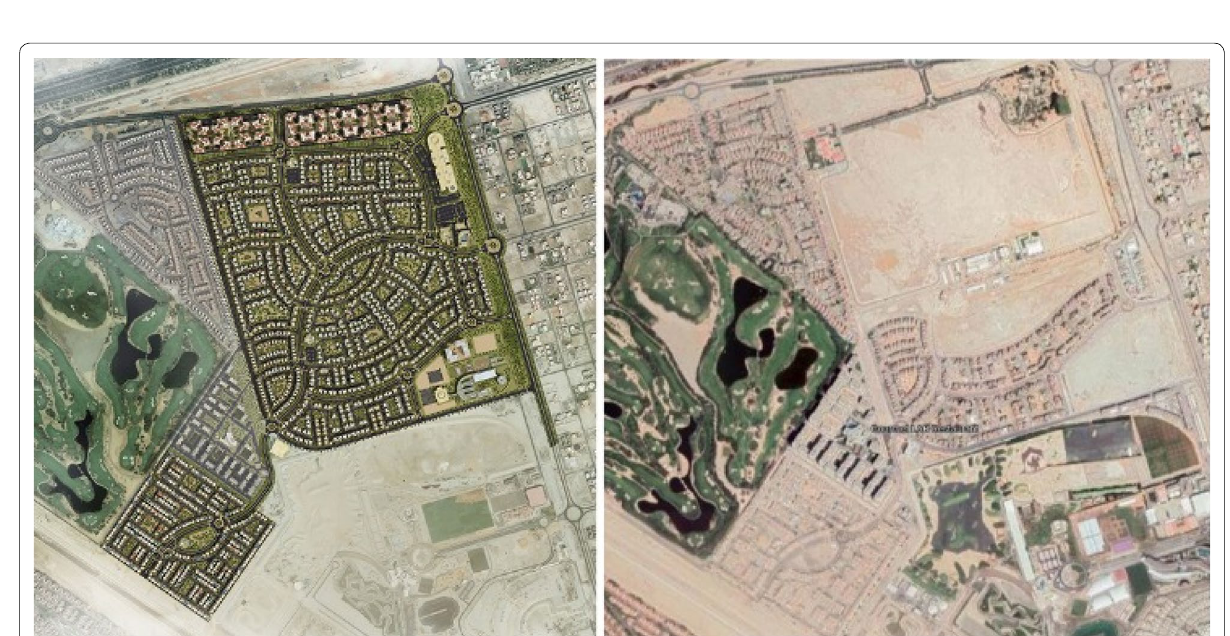
Fig. 3 A masterplan depiction (on the left) (Watani Housing Project 2015) and Google Maps picture of the implemented part of the project Al Watani, Khalifa City A, Abu Dhabi (on the